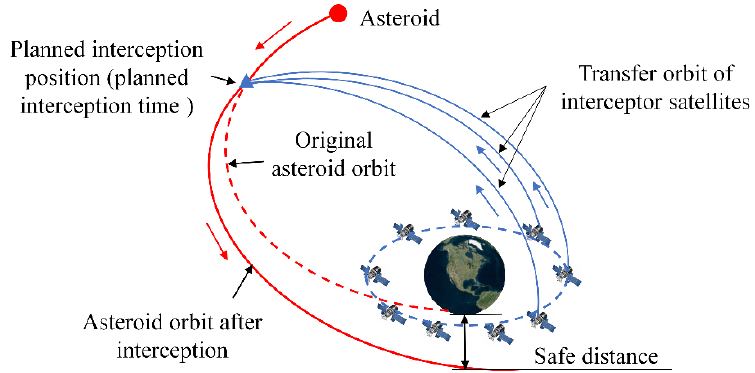
Figure 1. Schematic diagram of a cooperative asteroid-interception scene.